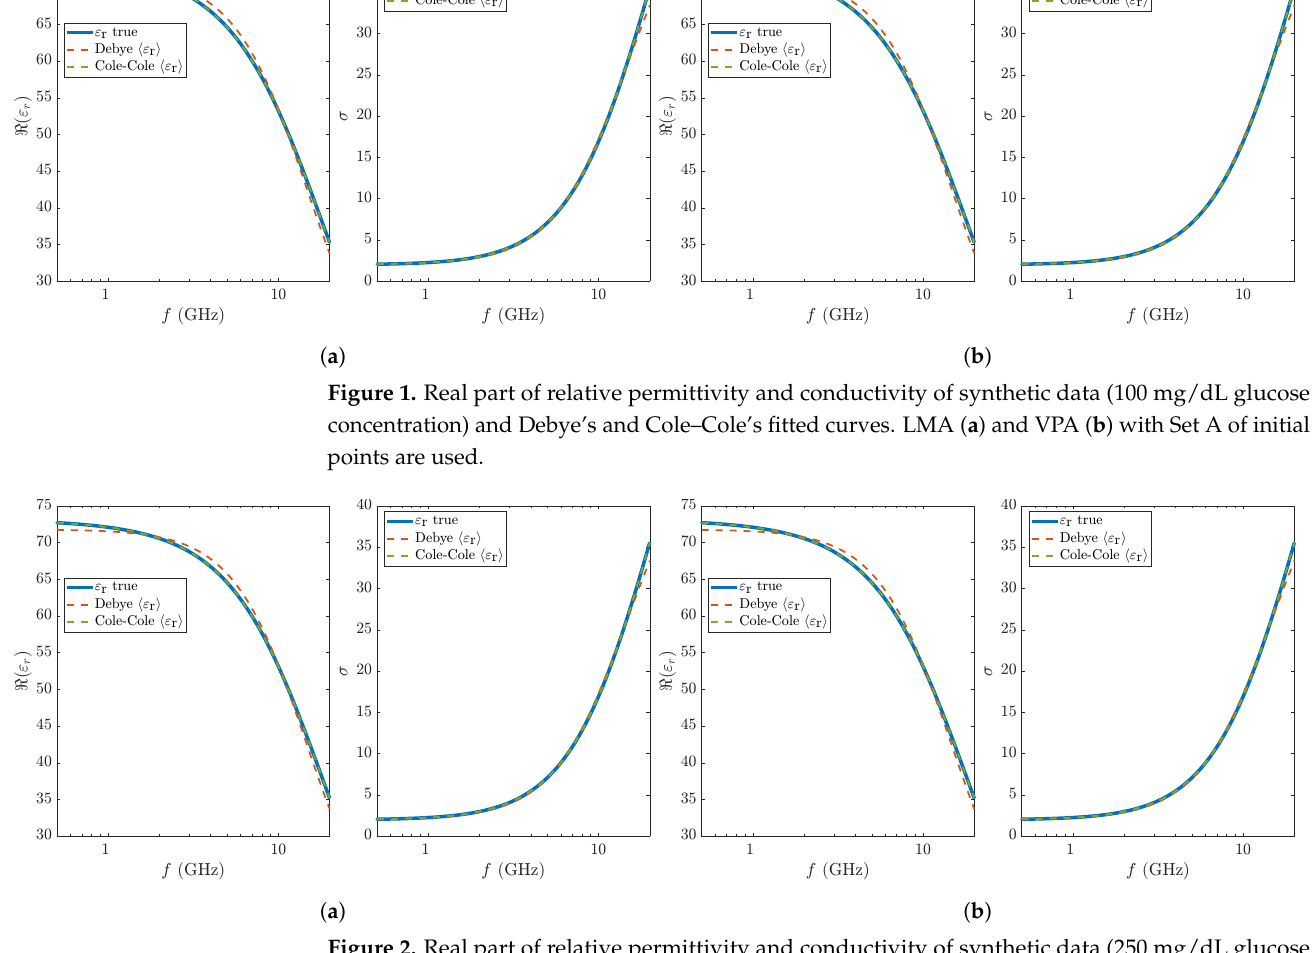
Figure 2. Real part of relative permittivity and conductivity of synthetic data (250 mg/dL glucose concentration) and Debye’s and Cole–Cole’s fitted curves. LMA ( a ) and VPA ( b ) with Set A of initial points are